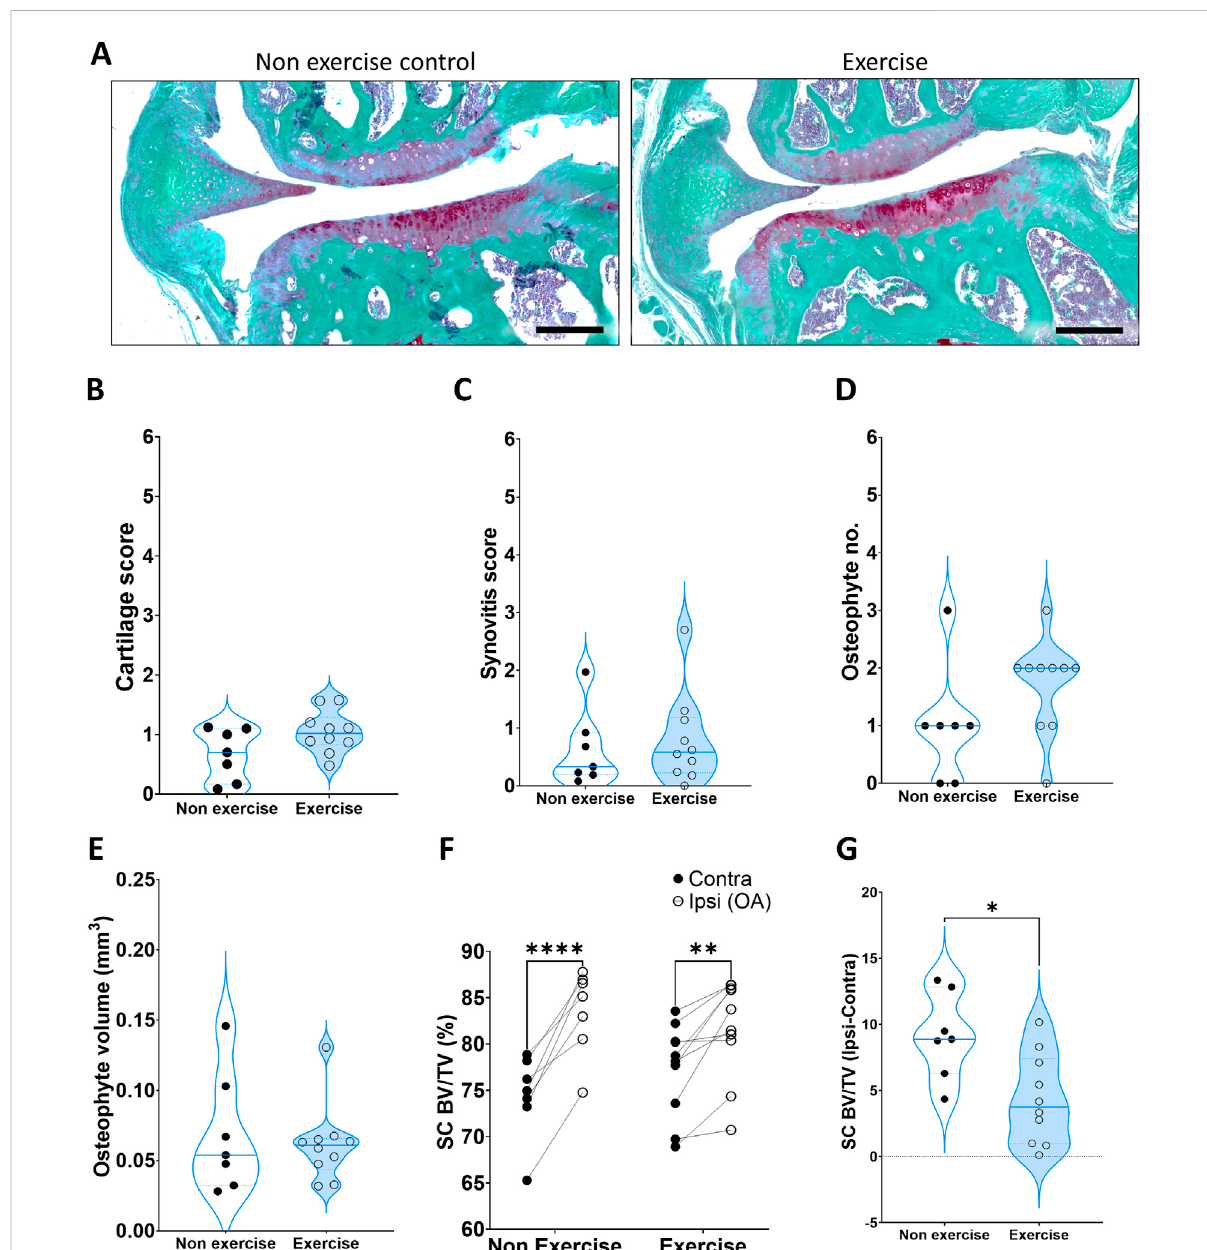
FIGURE 2 Disease parameters on mice 4 weeks after induction of OA. (A) Representative images of the DMM joint at 4 weeks, stained with SafraninO for cartilage and Fast Green for bone. (B) Cartilage score. (C) Synovitis score. (D) Osteophyte number. (E) Osteophyte volume. (F) Comparison ofmedial subchondralbone compartment density (% BV/TV) betweenthe operated ipsilateral (Ipsi) and control contralateral (Contra) legs. (G) Change intibial subchondral bone sclerosis (Ipsi – Contra). Comparison between exercise and non-exercise groups was done with a t-test unless data was not normally distributed,inwhichcase itwas thencomparedbyaMann-Whitneytest.Pairedcomparisonswereconducted viaapaired t-test. *p < 0.05, **p < 0.01, ***p <